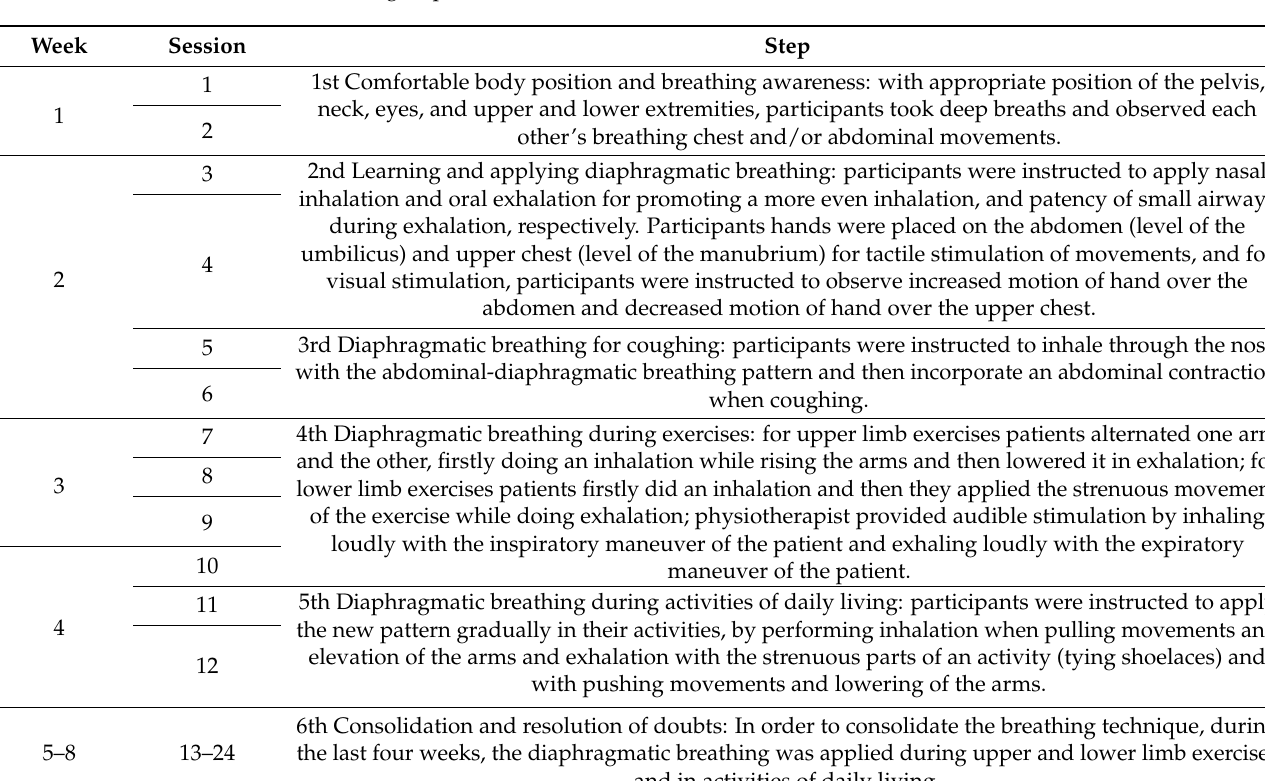
Table 1. Organization of weeks, sessions, and steps of the diaphragmatic breathing for the experi- mental